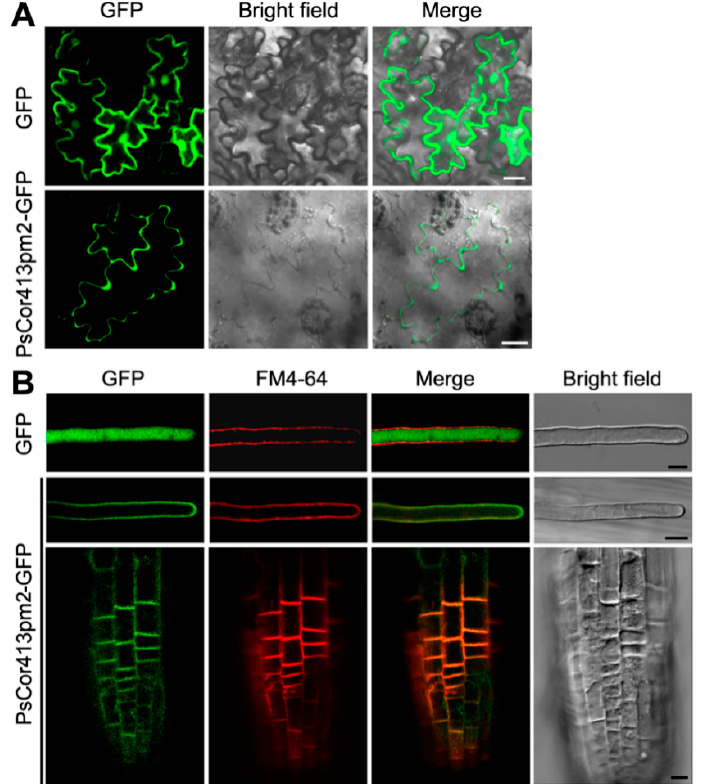
Figure 3. Subcellular localization of PsCor413pm2. ( A ) Confocal images of tobacco leaf epidermal cells transiently expressing GFP or PsCor413pm2-GFP are shown. ( B ) Confocal images of Arabidopsis root and root hair cells stably expressing GFP or PsCor413pm2-GFP incubated for 1 min with 4 µ M FM4-64 are shown. GFP fluorescence is green, and FM4-64 is red. Merge pictures were created by merging the GFP and FM4-64 fluorescent images. Scale bars = 10 μ m.